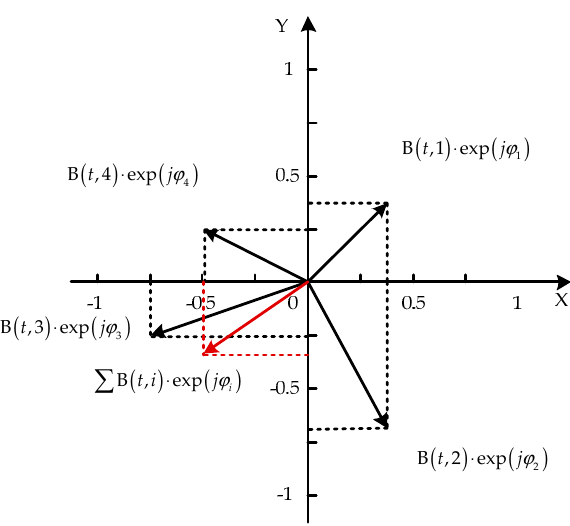
Figure 6. Sketch map of summation with random section length and random phase situation. The black arrows represent the vectors of four sections after MPSM, and the red arrow represents the summation of black arrows.